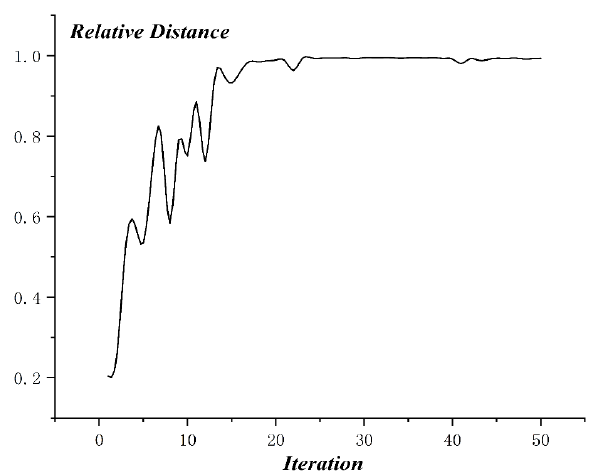
Figure 16. Optimization process of MSGWO.